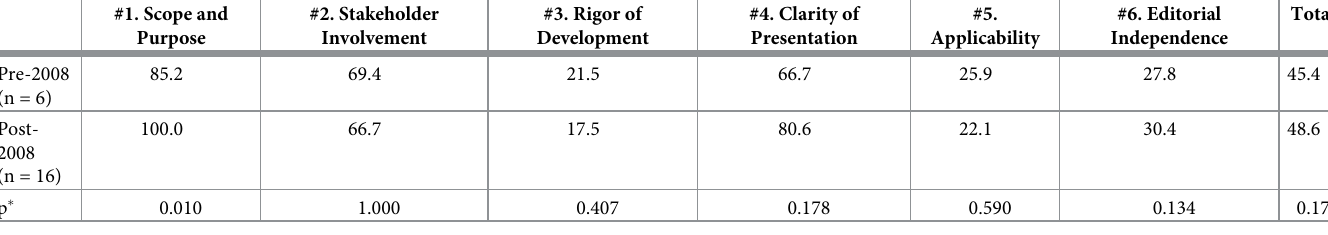
Table 3. Comparison between pre- and post-2008 groups in terms of median scores of clinical practice guidelines for patients (n = 22). #1. Scope and